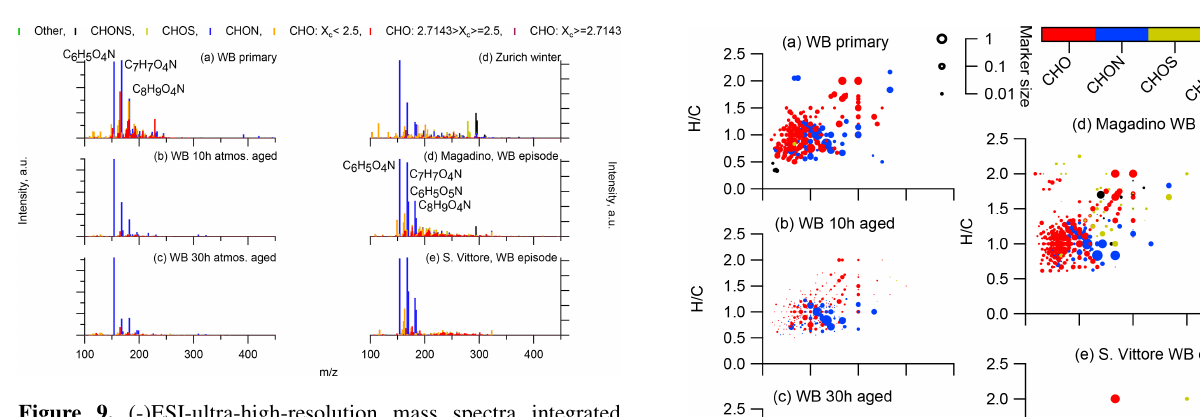
Figure 9. (-)ESI-ultra-high-resolution mass spectra integrated to unit-mass resolution of wood-burning laboratory experiments ( a primary emissions, b emissions after 10h atmospheric aging, c emissions after 30h atmospheric aging) and from winter wood- burning episodes at Alpine valley sites ( d Magadino, e San Vit- tore). The signal at a nominal mass is separated by ion family (CHON, CHOS, CHONS, other), and the signal of CHO com- pounds is separated by aromaticity (non-aromatic, X c >2.5; aro- matic, 2 . 5 ≤ X c <2.7143; condensed aromatic, X c ≥ 2 . 7143). Peak assignments of dominant ions of selected UMR peaks are labelled as neutral compounds.